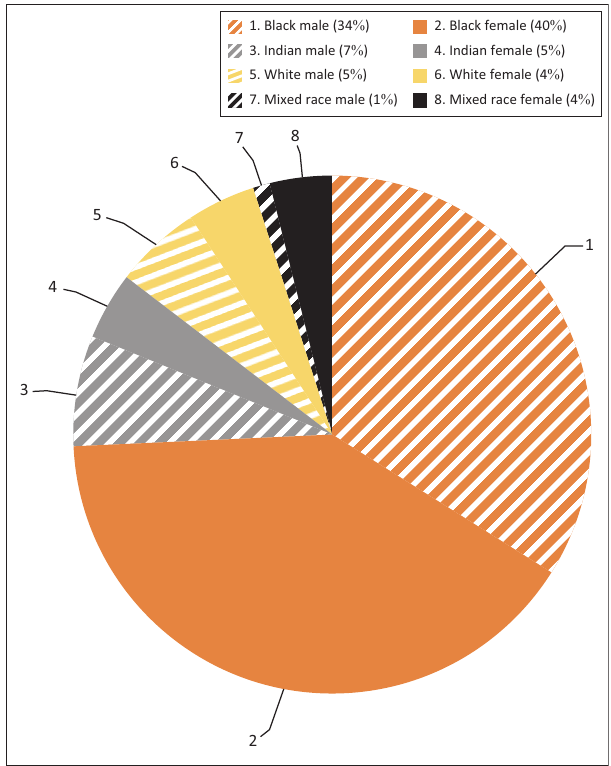
FIG URE 1: Pie graph representing the distribution of race and gender of the 206 keratoconus patients at the University of Johannesburg contact lens clinic over the period January 2007 to December 2017. Only patients with at least one good quality Pentacam scan were included in the sample.